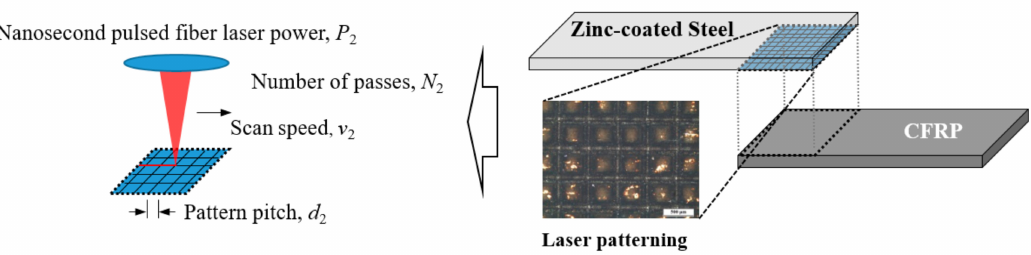
Figure 2. Schematic of the laser surface pattered zinc-coated steel using a nanosecond pulsed fiber laser. The pre-inscribed rectangular pattern is formed by irradiation of a laser with a power of P 2 , the number of passes as N 2 , and a scan speed of v 2